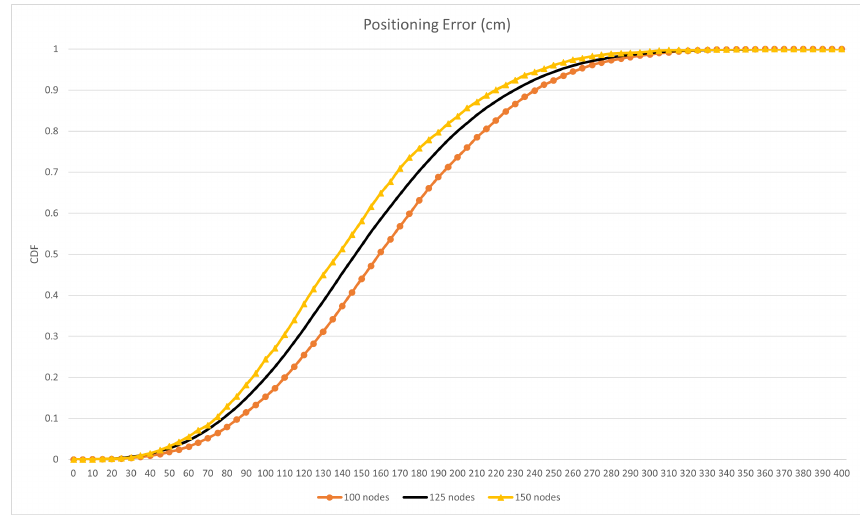
Figure 13. Positioning error (cm).